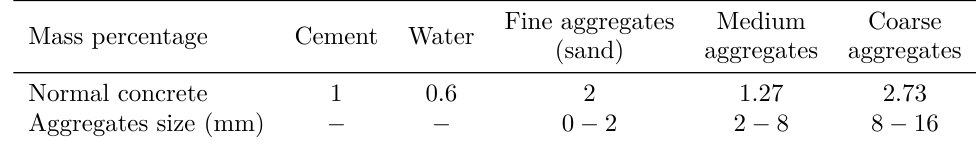
Table 2. Designed mixing ratio for concrete.